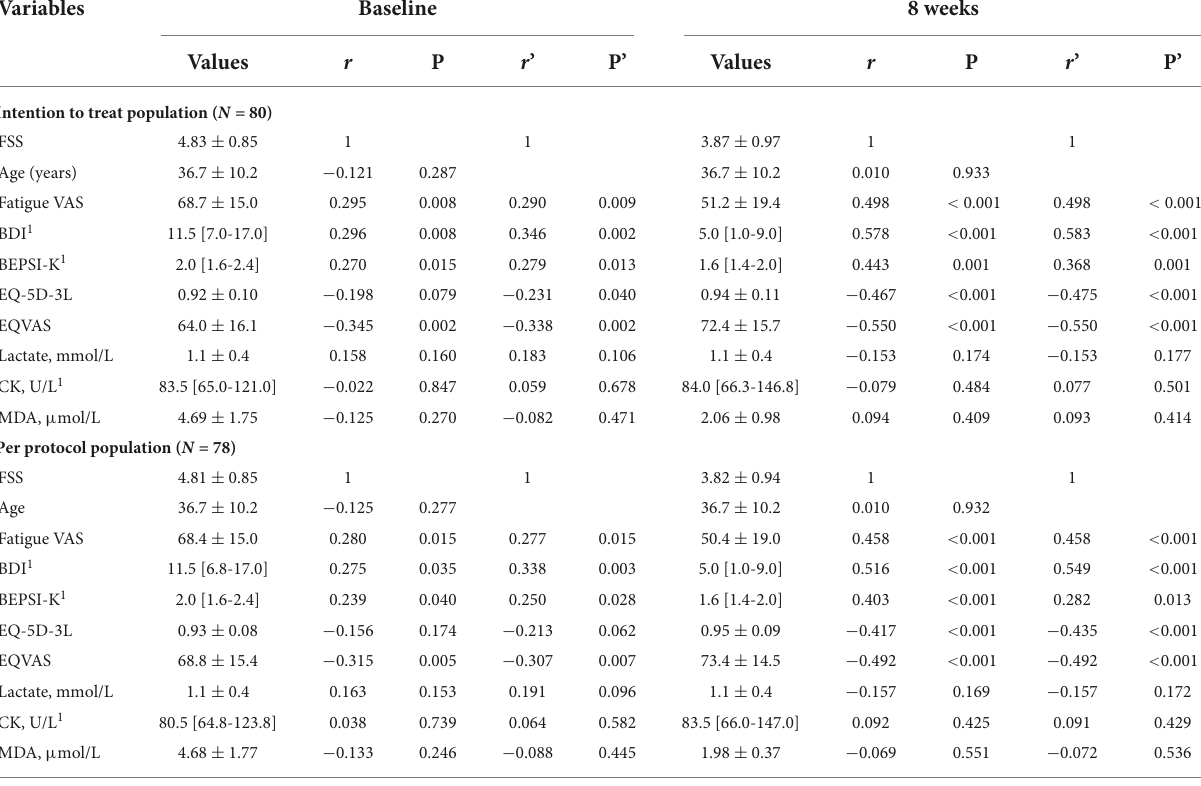
TABLE 4 Pearson’s correlation coefficient and partial correlation between fatigue severity scale and other fatigue indices.